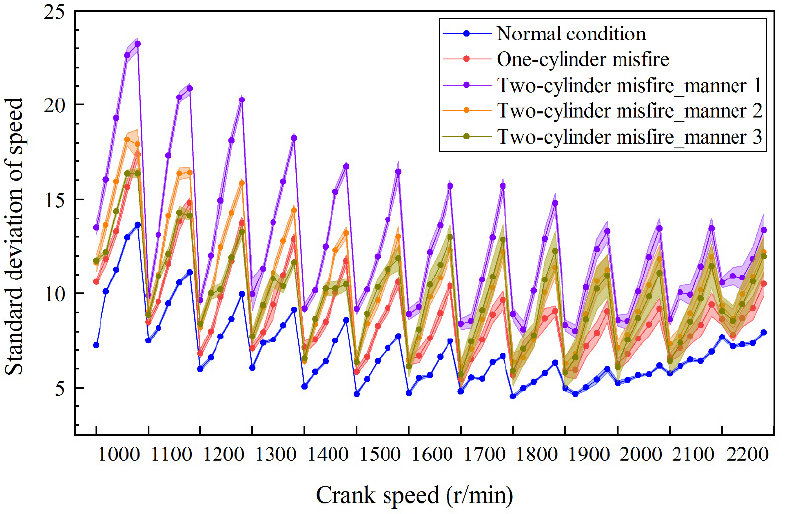
Figure 7. Standard deviation of one cycle speed under different speeds and loads with different misfire patterns. Fill areas mean error bars. Under each speed, the five points from left to right in a curve represent the five loads which are no-load, 100 Nm, 150 Nm, 200 Nm and 250 Nm. Moreover, manner 1, manner 2 and manner 3 have the same meaning with those in Figure 6.